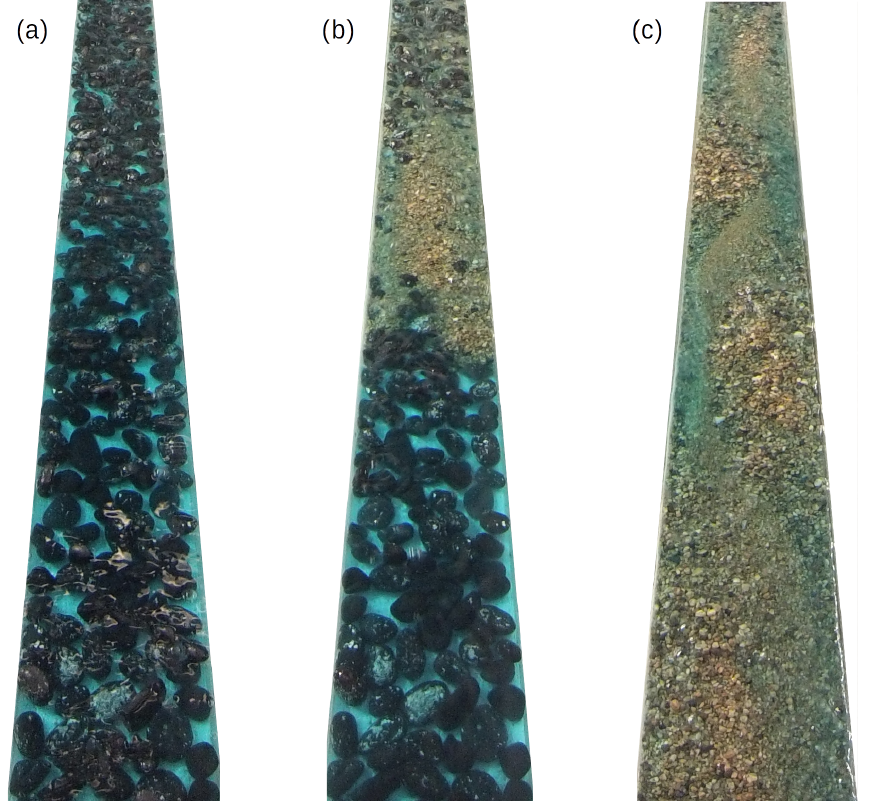
Figure 3. Example images of the black roughness elements used to force subcritical flow, and their submergence taken during (a) beginning of experiment with full emergence, (b) partial submergence and (c) onset of transport, almost complete burial and submergence, from experiment 200H using GSD broad